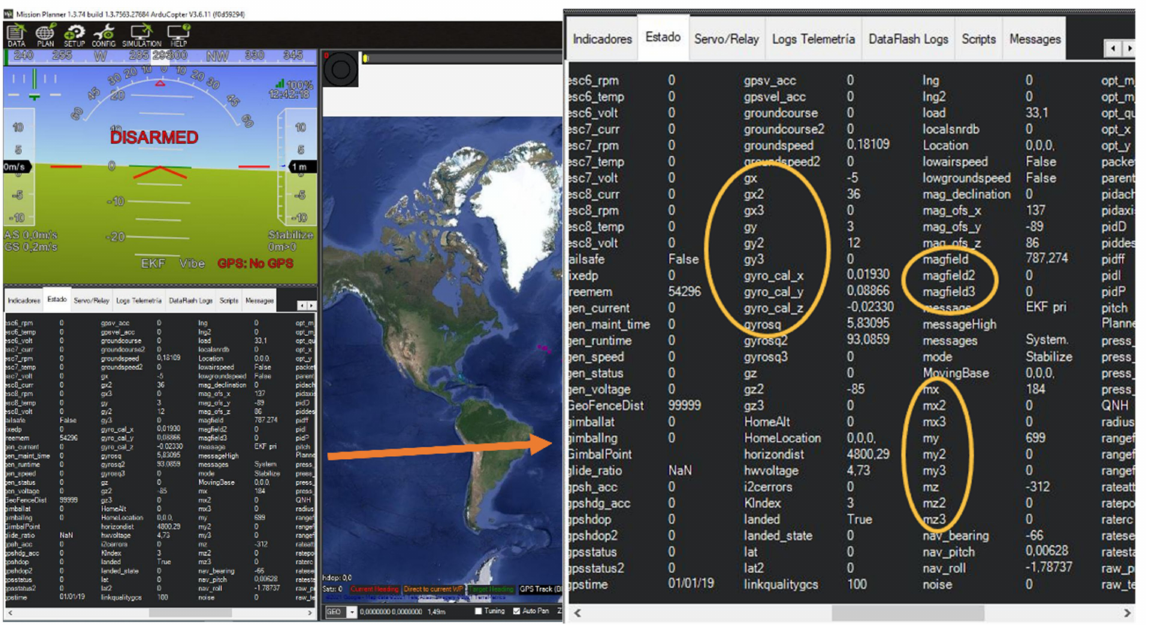
Figure 3. Mission Planner Pixhawk data display, highlighting some sensor data as magnetometer or gyroscope measurements.